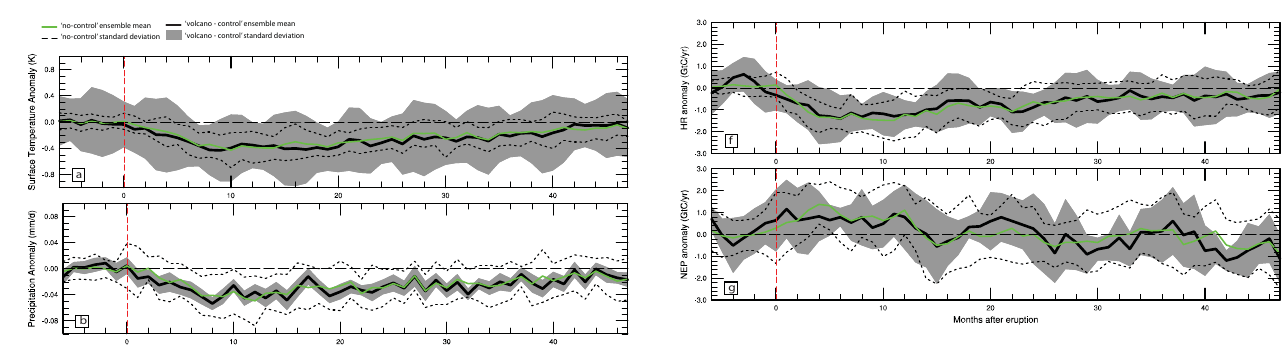
Fig. 8. Globally averaged (a–b) and integrated (c–g) monthly anomalies for the indicated variables, computed using both the “volcano–control” and “no-control” methods, averaged and com- posited for the 5 denoted eruptions in Table 1. Mean anomalies for each method are depicted with black and green lines, respectively, and the corresponding standard deviation is shown as a shaded area (“volcano–control”) and dotted lines (“no-control”). X-axis is months after eruption (dashed red line). Positive surface flux indi- cates uptake by